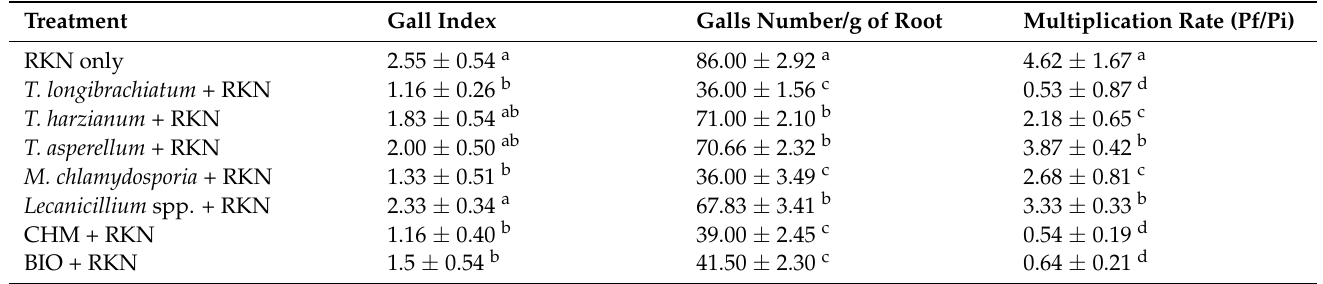
Table 5. Root-knot nematode, M. javanica, development indices under various treatments, 60 days after inoculation.